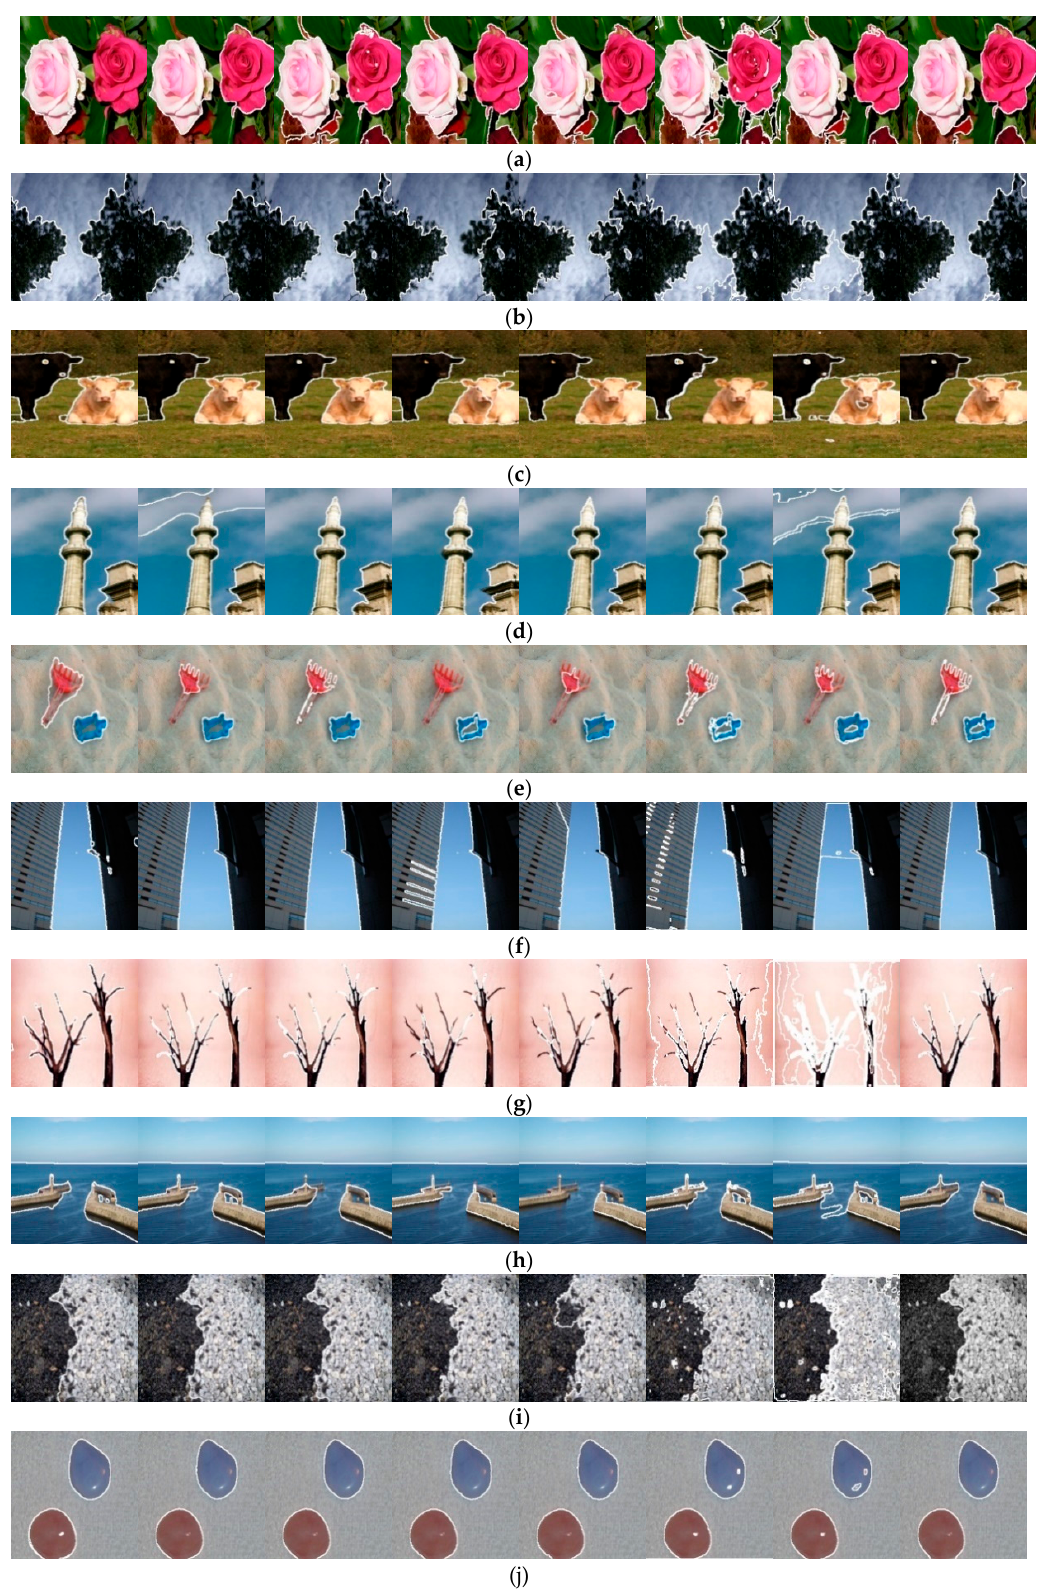
Figure 2. Comparative segmentation results for various algorithms. ( a – j ) are images from [49–52]. The 1st to the 8th columns are the results for FRCGMM, L1FS, PCFRC, SFFCM, AFCF, BP, DFC and FBRC,